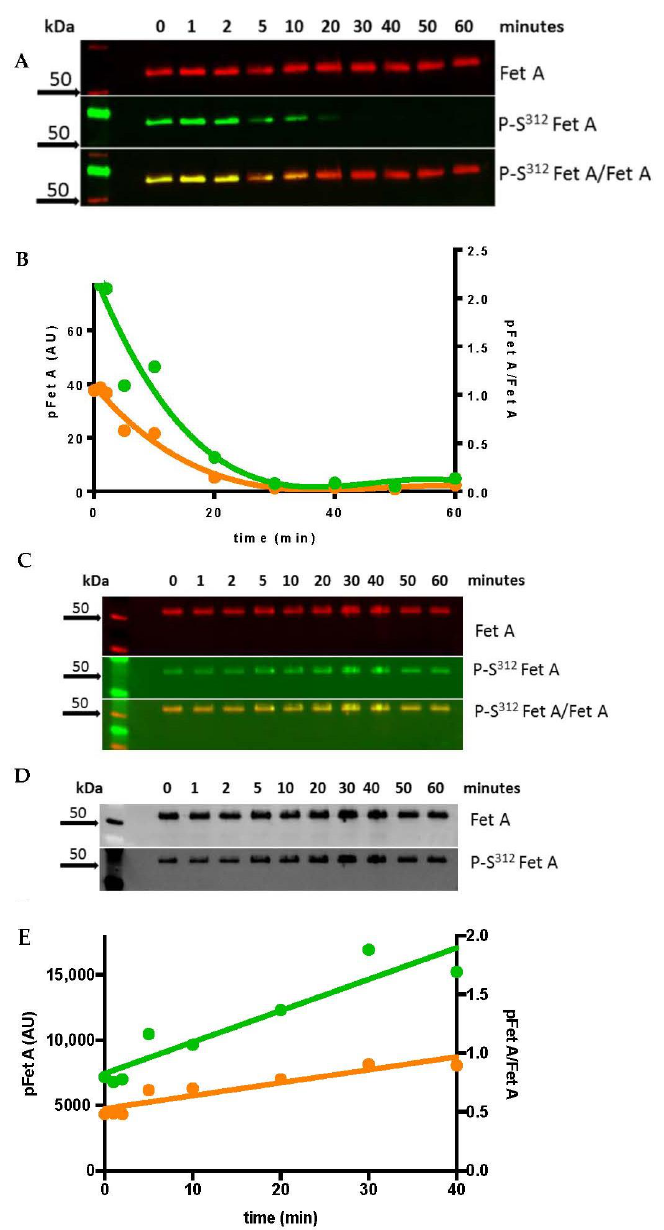
Figure 1. Enzymatic dephosphorylation and phosphorylation of Fet A. ( A ) Western blot analysis of time-dependent λ -phosphatase-catalyzed dephosphorylation of Fet A (red) pFet A (green) and overlay pFet A/Fet A (yellow/red). ( B ) Densitometric evaluation of Western blot data of pFet A (green) and pFet A/Fet A (orange) is shown. A representative Western blot is shown, three experiments have been performed. ( C ) Western blot analysis of time-dependent phosphorylation of commercial Fet A with FAM20C. ( D ) For comparison, the same Western blot was also developed by the conventional chemiluminescence method. ( E ) This figure shows the densitometric evaluation of the time-dependent phosphorylation of commercial Fet A. For detailed description of the procedure and the quantification see the Methods section. Bold arrows indicate molecular weight marker; AU, arbitrary